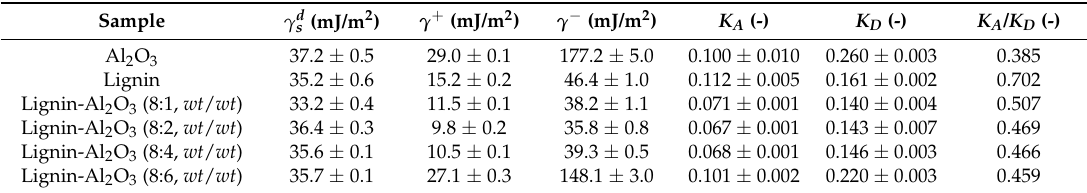
Table 4. Dispersive, ( γ d s ) donor-acceptor ( γ +, γ − ) components of the free surface energy of studied hybrid fillers and comparison with alumina and lignin.